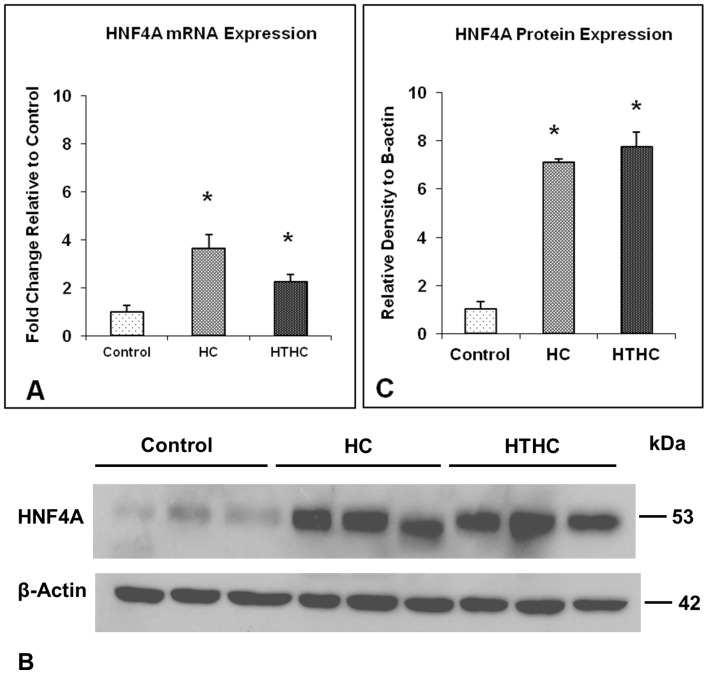
HNF4A expression in the aorta.(A) Real-time RT-PCR analyses of HNF4A in the aorta of control, hypercholesterolemia plus sham, and hypertension plus hypercholesterolemia rabbits. The mean and standard error are shown. *p<0.05 vs. controls by one-way ANOVA with Bonferroni’s multiple comparison post-hoc test (n = 4 in each group). (B) Western blot analyses of HNF4A in the aorta of control, hypercholesterolemia plus sham and hypertension plus hypercholesterolemia rabbits. (C) Densitometric analyses of HNF4A protein, normalized to ß-actin. The mean and standard error are shown. *p<0.05 vs. control by one-way ANOVA with Bonferroni’s multiple comparison post-hoc test (n = 3 in each group). Abbreviations as in Fig. 1.